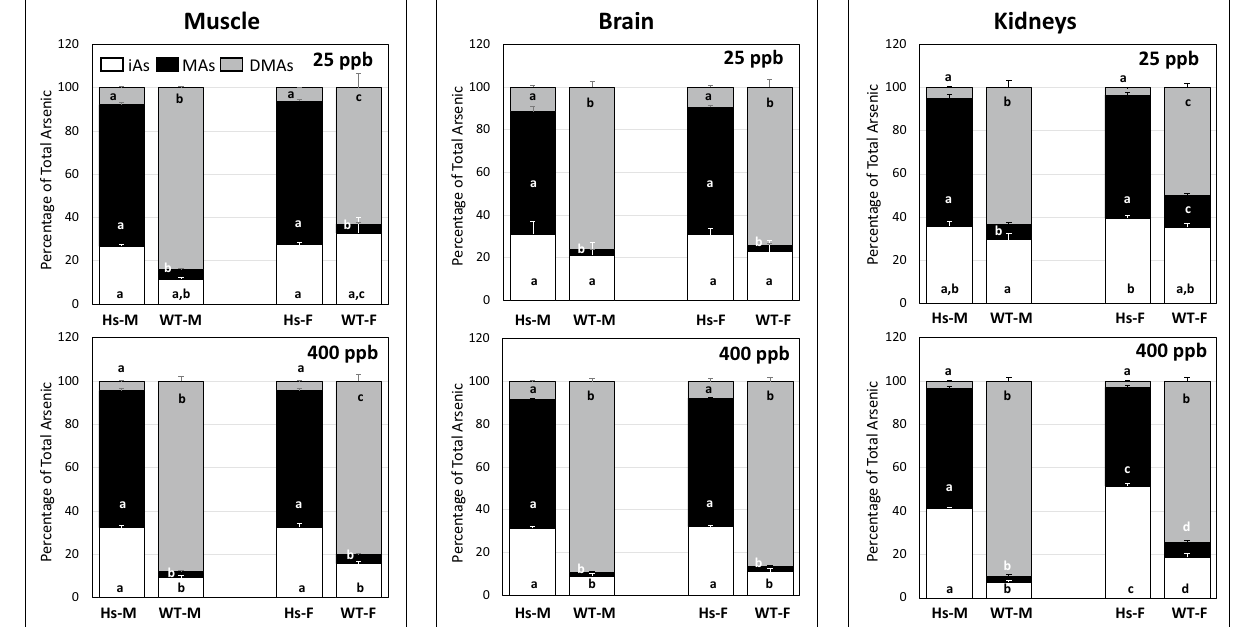
Figure 7. Percentages of total arsenic represented by inorganic arsenic (iAs), methylarsenic (MAs), and dimethylarsenic (DMAs) in muscle, brain and kidneys of humanized (Hs) and wild-type (WT) male (M) and female (F) mice after 4-week exposure to 25-ppb or 400-ppb of inorganic arsenic in drinking water: The tissues of Hs mice with highest percentages of MAs and the corresponding tissues of WT mice are shown. Each bar and whisker represent mean and SEM value, respectively. For 25-ppb exposure, N = 6 for Hs males and WT males, and N = 8 for Hs females and WT females. For 400-ppb exposure, N = 7 and 8 for Hs males and WT males, respectively, and N = 10 and 11 for Hs females and WT females, respectively. For each arsenic species, values marked with different letters are significantly different (p <